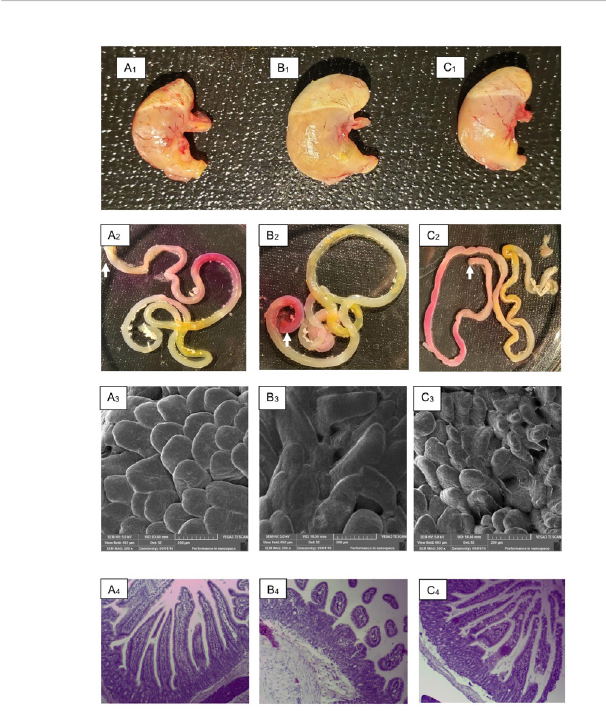
FIGURE 2 - Effects of melatonin (MLT) on cisplatin (CP)- induced gastrointestinal damage in mice. Gross anatomy of mice stomachs after excision from the abdomen (section 1), upper intestinal dye transit (section 2), scanning electron microscopy (SEM) images acquired at 10 kV (section 3), and qualitative optical microscopy (100×, section 4) showing the luminal surface of the duodenum. Box A : control group, 1-4 animals treated with vehicle (ethanol 5% in NaCl 0.15 M); Box B : Cisplatin group, animals treated with 5 mg/kg 1-4 CP; BOX C : melatonin group, animals pretreated with 1-4 20 mg/Kg MLT plus 5 mg/kg CP. White arrow: Proximal